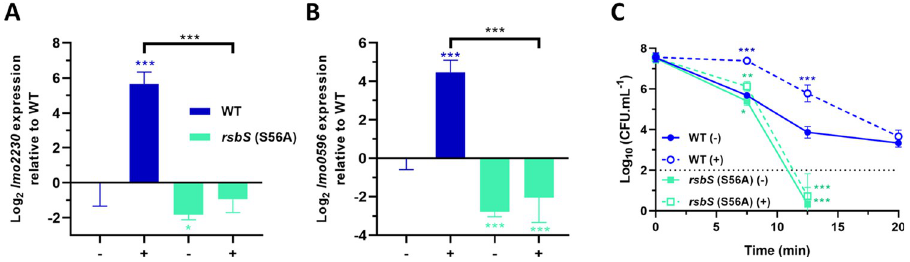
Fig 5. RsbS residue S56 is essential for the transduction of the low pH signal and activation of σ B . Expression of σ B -dependent genes (A) lmo2230 and (B) lmo0596 , obtained from mid-log phase cultures of wild type and rsbS (S56A) strains untreated (-) and treated (+) for 15 min in pH 5.0 at 37˚C. Gene expression is represented as Log 2 relative gene expression. (C) Acid challenge of mid-log phase cultures treated in pH 5.0 for 15 min at 37˚C, as previously described in Fig 2D. Survival data is expressed as Log 10 (CFU.mL -1 ). Statistical analysis was performed using a paired Student’s t - test relative to the wild type untreated after 15 min, for RT-qPCR data, and untreated wild type at time 0 min, for acid challenge data ( � , P value of < 0.05; �� , P value of < 0.01; ��� , P value of < 0.001).